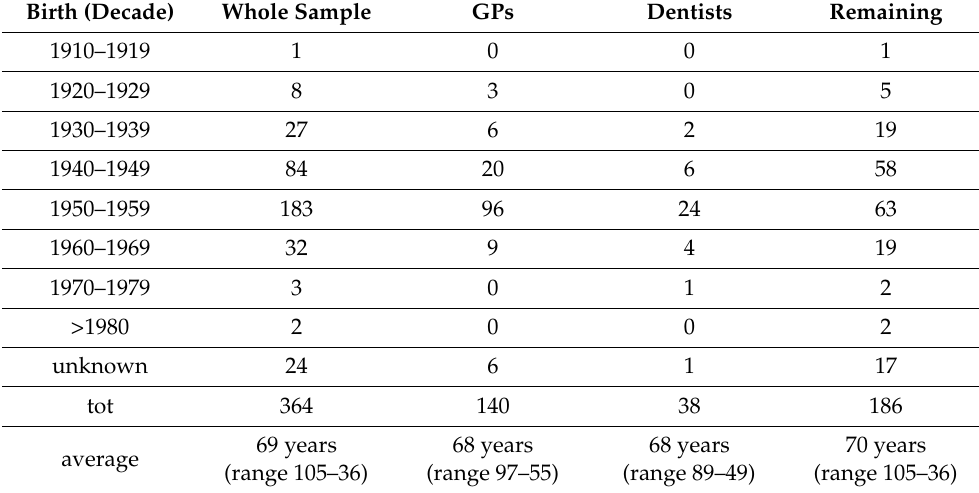
Table 1. Age distribution of the whole sample, GPs, dentists and remaining doctors.